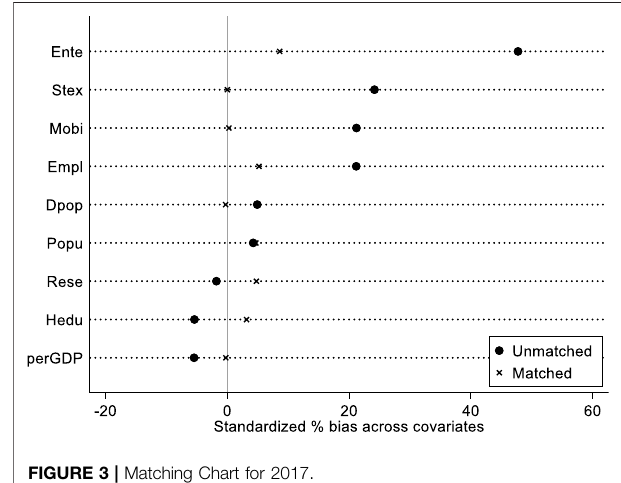
FIGURE 3 | Matching Chart for